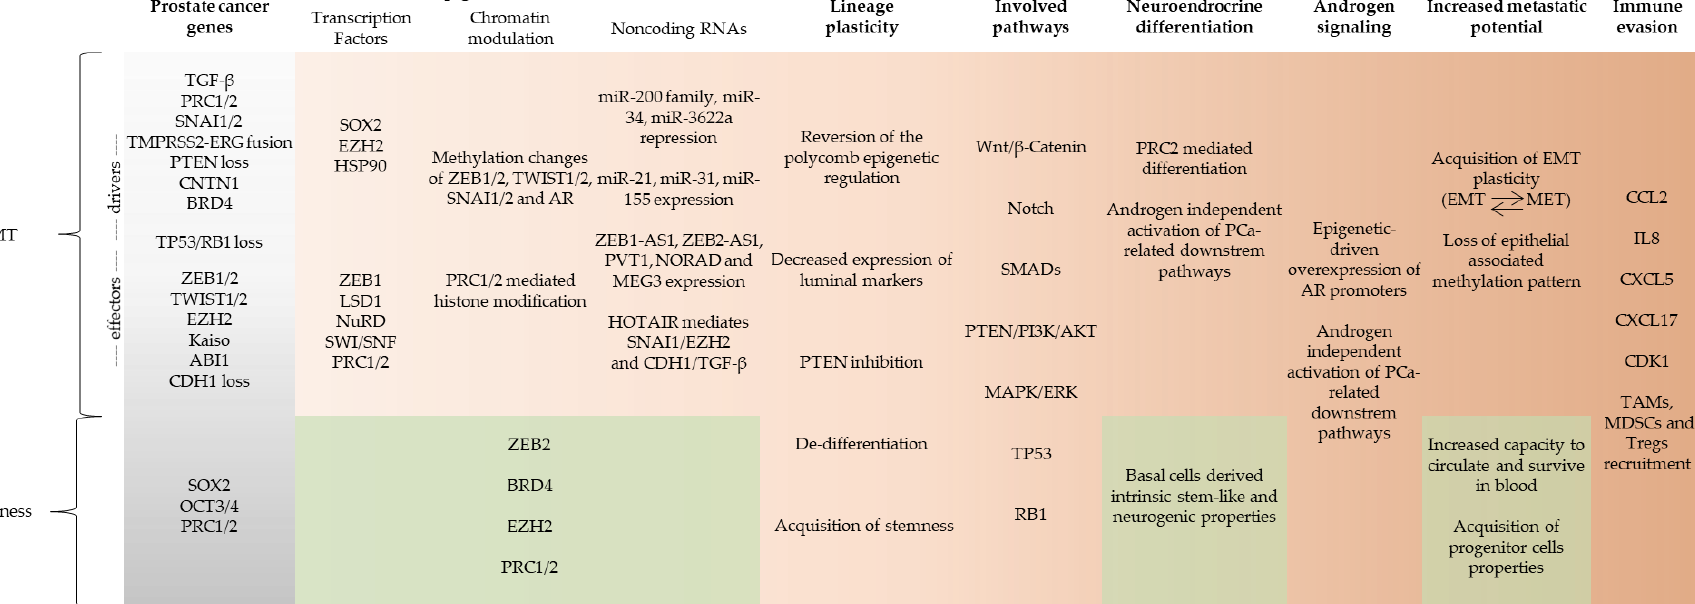
Figure 2. Schematic depiction of regulation of EMT and stemness related to PCa progression. Somatic mutations of prostate cancer are thought to lead to molecular changes in transcription factors, chromatin modifiers, and noncoding RNA involved in EMT and stemness. The consequences of the epigenetic changes initiated by EMT driver transcription factors reprograms chromatin, conferring epigenetic and transcriptional changes to downstream EMT effector genes [16]. These alterations can contribute to plasticity and alterations to other genes and pathways that promote the phenotypic and molecular changes of EMT and stemness during PCa progression [18,62]. The horizontal left to right axis shows the various genetic and epigenetic processes activating pathways of progression (with increasing orange intensity) to mCRPC. Stemness and EMT have closely related prostate cancer somatic genetics (shown as a grey gradient, left side), and specific stemness features during progression are depicted in pale green (lower panels).